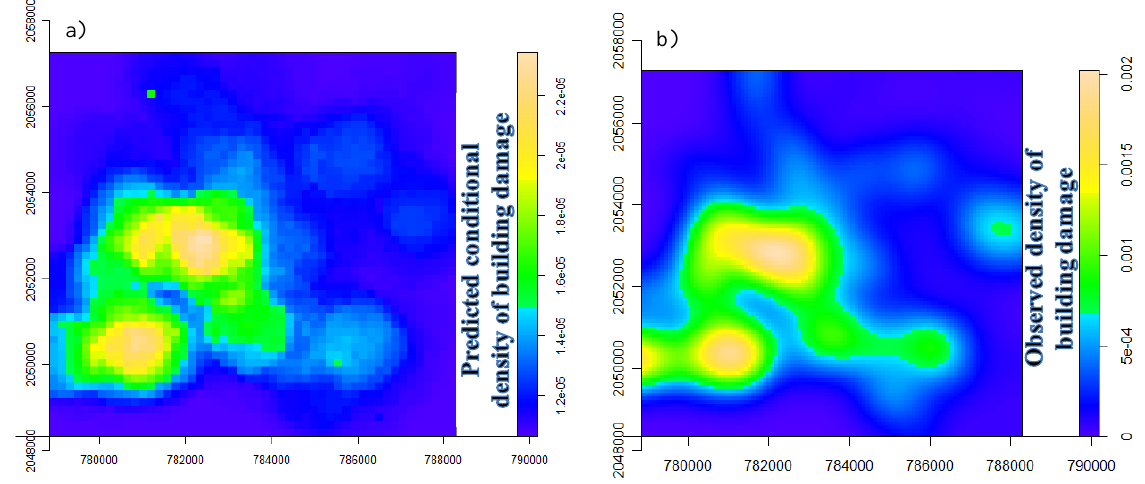
Figure 7. Predicted conditional density of building damage (7a) compared to the actual 2 Fig. 7. Predicted conditional density of building damage (a) compared to the actual building damage density (b) .